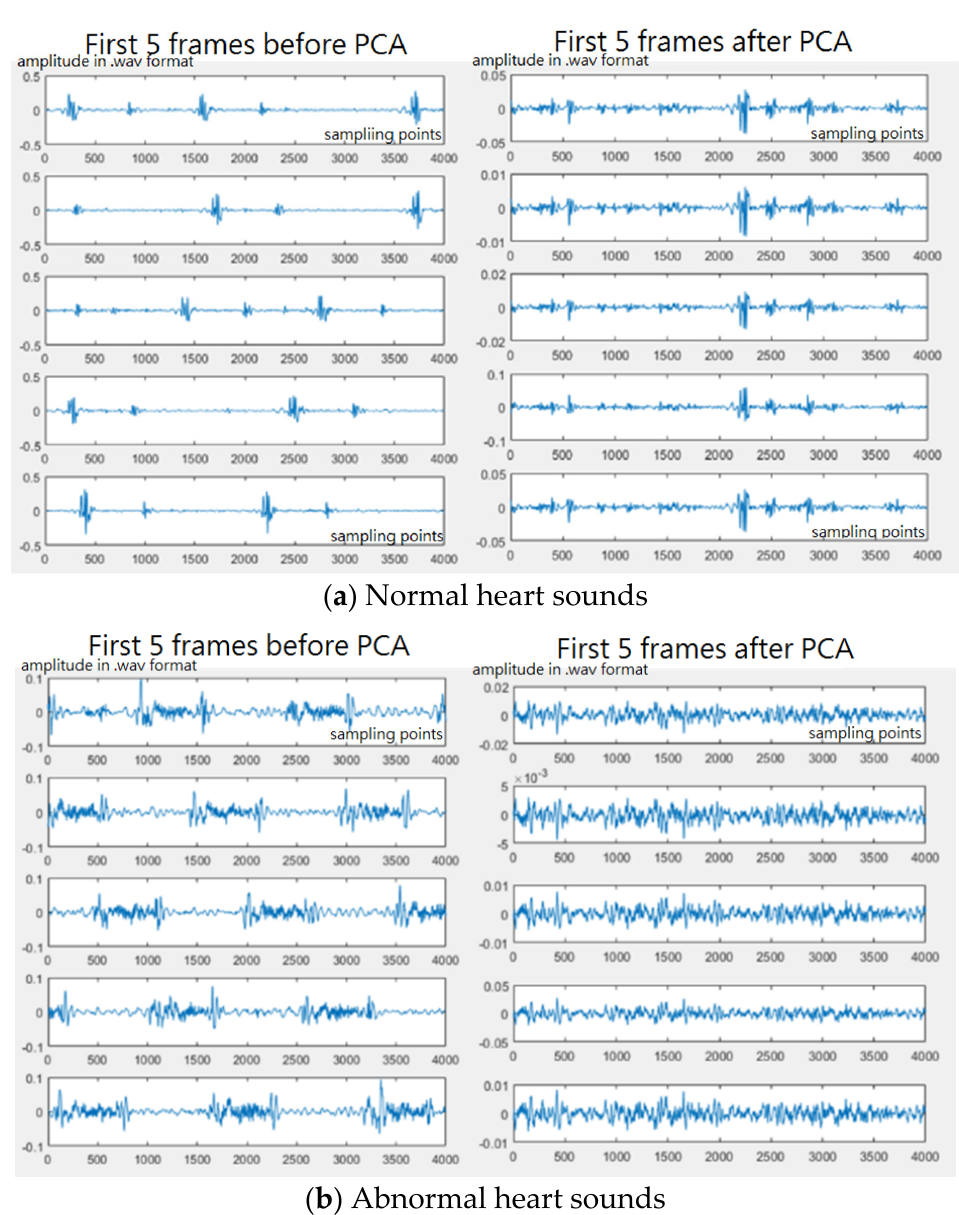
Figure 9. ( a ) Normal heart sounds before/after PCA and ( b ) abnormal heart sounds before/after PCA.